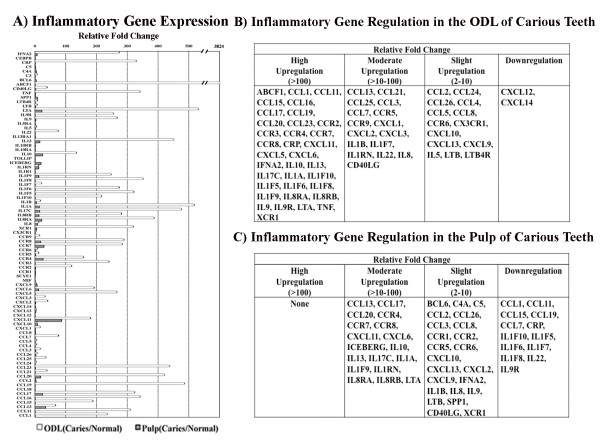
Quantitative analysis for differential changes in the odontoblast layer (ODL) and pulp of carious teeth. Expression of inflammatory genes in ODL and pulp of normal versus carious teeth was determined by real-time quantitative PCR arrays (A-C). The fold change of gene expression detected by PCR arrays was more robust than that determined by cDNA arrays. However, the overall regulatory profile was similar: the increase of inflammatory gene expression in carious teeth was much more profound in ODL than in the pulp. Values are reported as relative fold change in mRNA transcription of carious versus normal samples. The data represent means and standard errors from triplicate sets of array analyses. Abbreviations: IFNA2, Interferon alpha 2; CEBPB, Enhancer binding protein beta; CRP, C-reactive protein; C4A, complement component 4A; BCL6, B-cell CLL/lymphoma 6; ABCF1, ATP-binding cassette, subfamily F member 1; CD40LG, CD40 ligand; TNF, Tumor necrosis factor alpha; SPP1, Secreted phosphoprotein 1 (osteopontin, bone sialoprotein I, early T-lymphocyte activation 1); LTB4R, Leukotriene B4 receptor; LTB, Lymphotoxin beta; LTA, Lymphotoxin alpha; TOLLIP, Toll-interacting protein; ICEBERG, ICEBERG caspase-1 inhibitor; IL, Interleukin; IL1R1, Interleukin 1 receptor, type I; IL1RN, Interleukin 1 receptor antagonist; IL10RA, interleukin 10 receptor alpha; IL10RB; interleukin 10 receptor beta; IL1F9, Interleukin 1 family member 9; XCR1, Chemokine (C motif) receptor 1; CX3CR1, Chemokine (C-X3-C motif) receptor 1; CCR, Chemokine (C-C motif) receptor; SCYE1, Small inducible cytokine subfamily E member1 (endothelial monocyte activating); MIF, Macrophage migration inhibitory factor; CXCL, Chemokine (C-X-C motif) ligand; CCL, Chemokine (C-C motif) ligand.